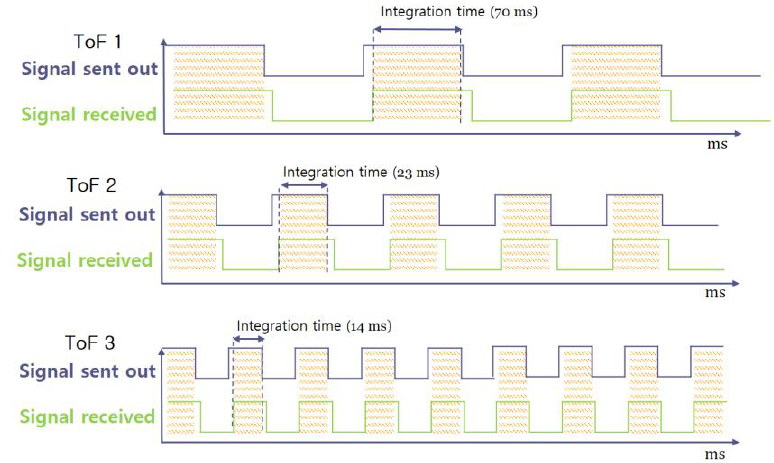
Figure 5. Three di ff erent signals with di ff erent integration Figure 5. Three different signals with different integration times.